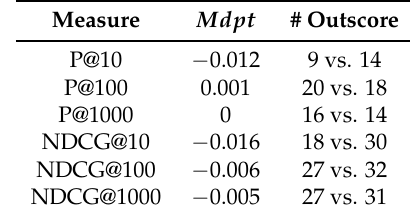
Table 25. T1: comparison of the best run vs. the reciprocal ranking (RR) fusion of the two best runs.